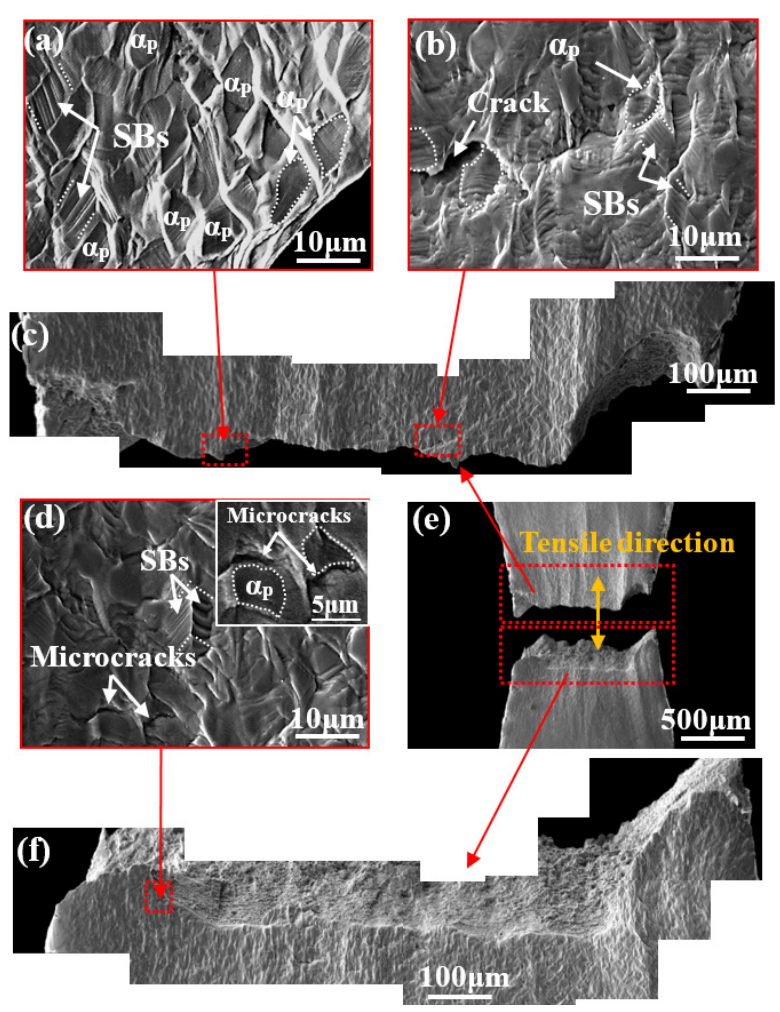
Figure 7. ( a ) The streamlined shape of the β matrix near the fractured zone at position C; ( b ) a crack propagated along the α p / β interface; ( c , f ) SEM images showing the rough fracture surface of the sample; ( d ) magnified image showing intensified SB formation in the α p phase and microcracking at the α p / β interface; ( e ) macroscopical SEM images of the bimodal microstructure at position C.